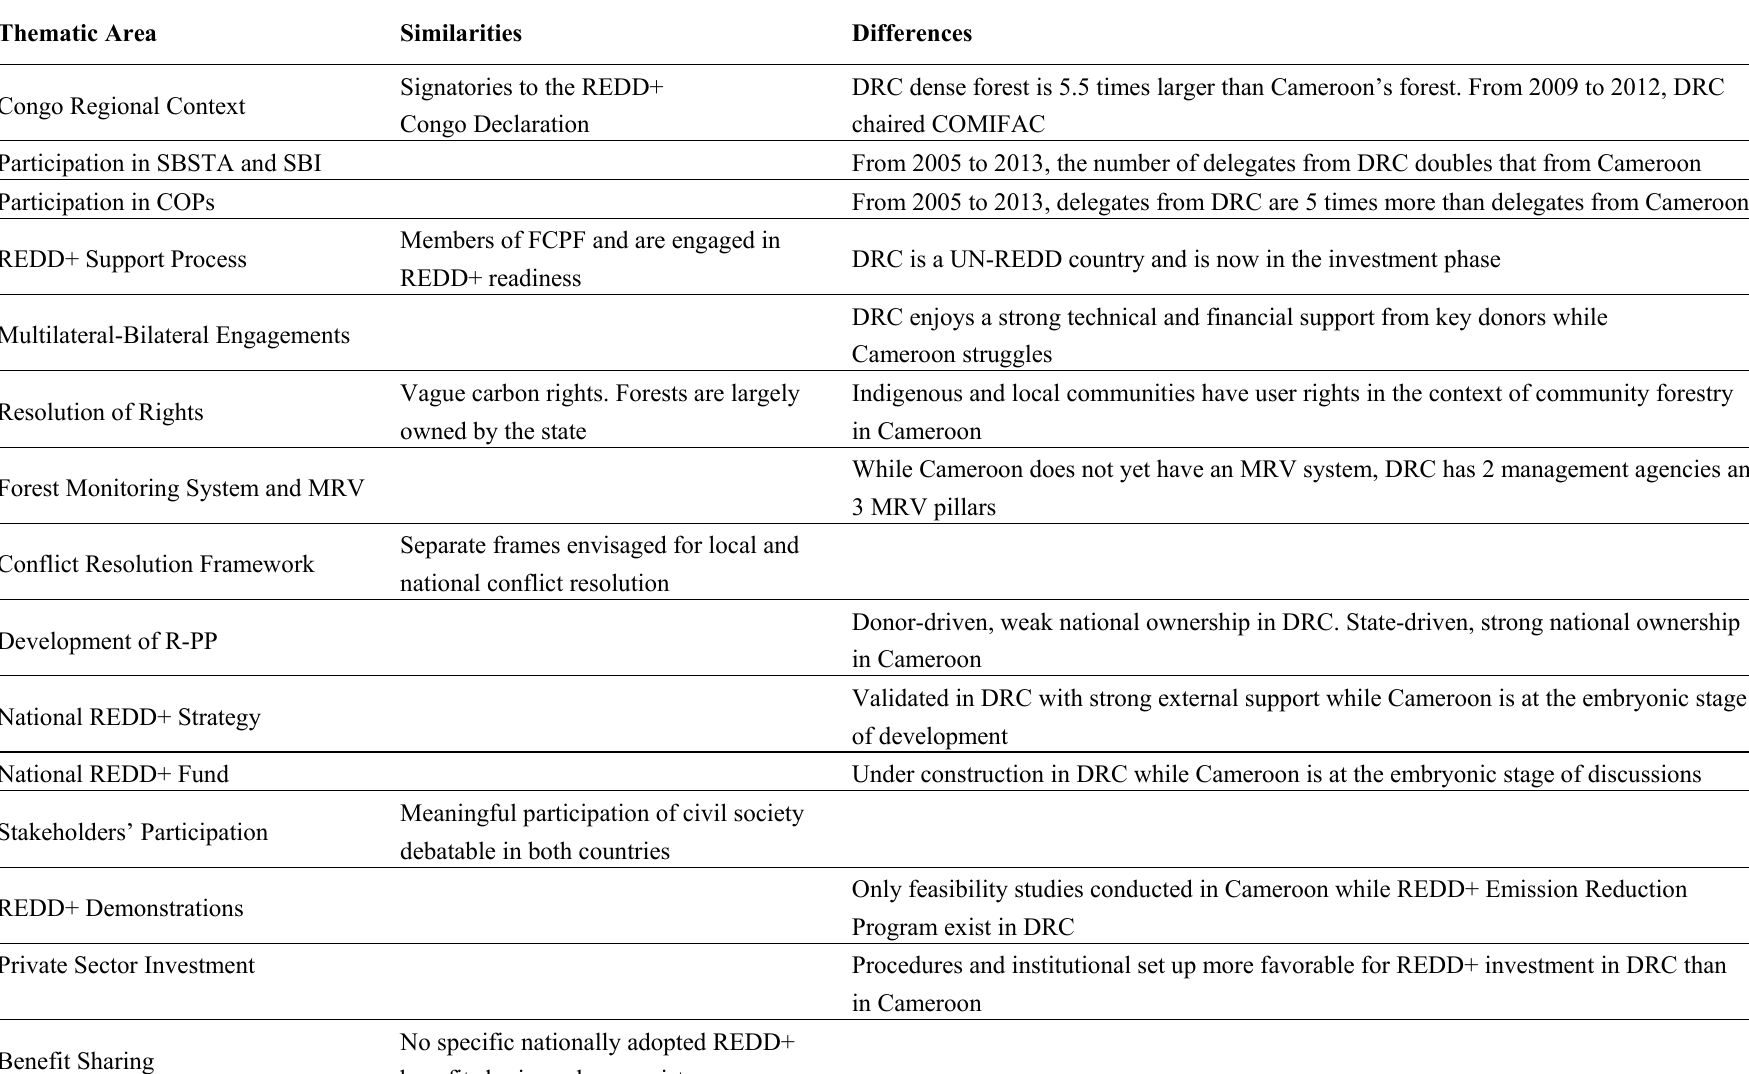
Table 4. Key similarities and differences of REDD+ policy approaches in DRC and